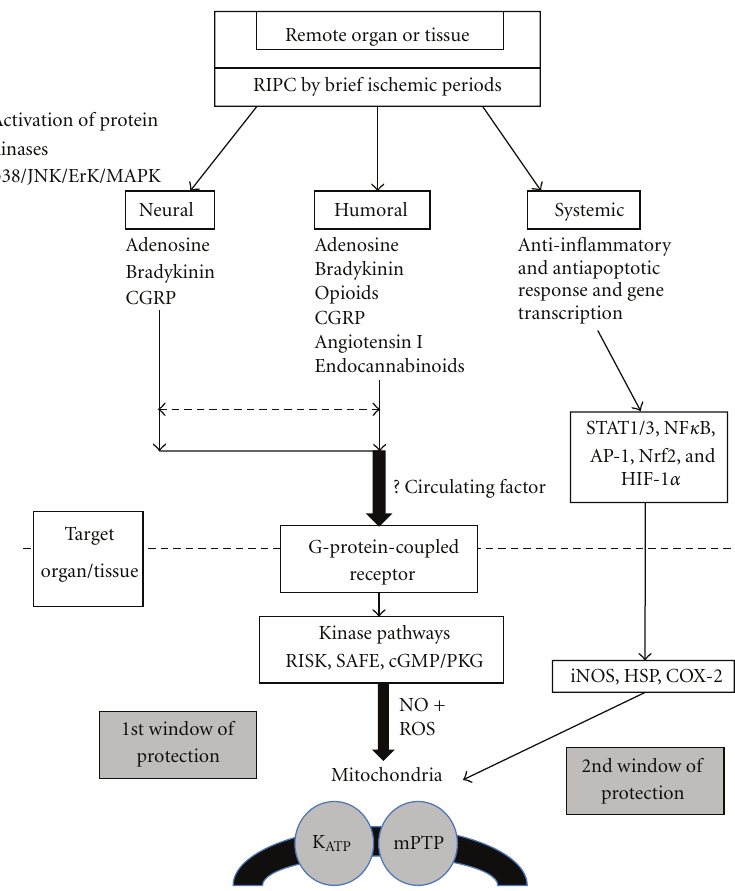
Figure 1: proposed mechanisms of remote ischemic